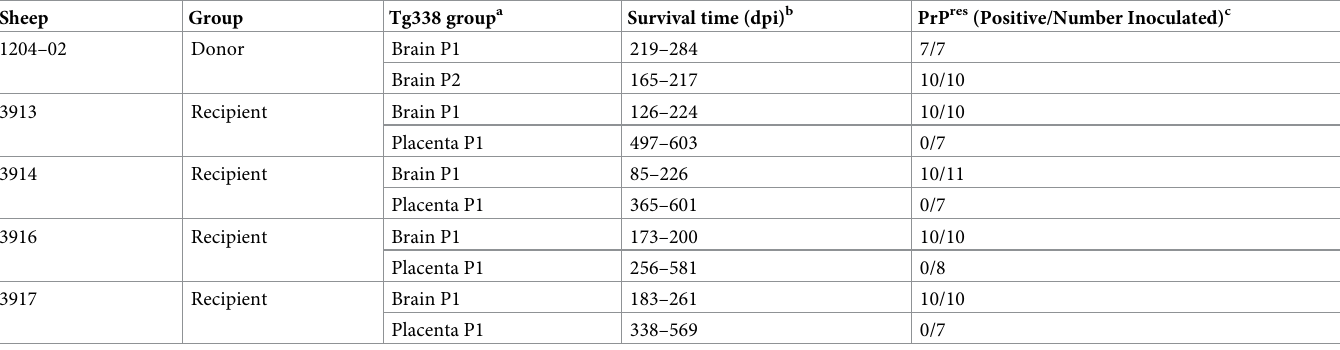
Table showing survival times and PrP res detection in mice intracerebrally inoculated with brain or placental cotyledon homogenates from donor or recipient ewes. a P1 represents first passage inoculation with sheep tissue homogenate. P2 represents second passage inoculation with mouse brain tissue from P1 mice. b Survival time range—days post inoculation (dpi) of mice culled due to the presence of clinical signs (Tg338 inoculated with brain homogenate) or intercurrent issues (Tg338 inoculated with brain or placenta homogenate). c Number of mice with PrP res by PTA-western blot versus number of mice